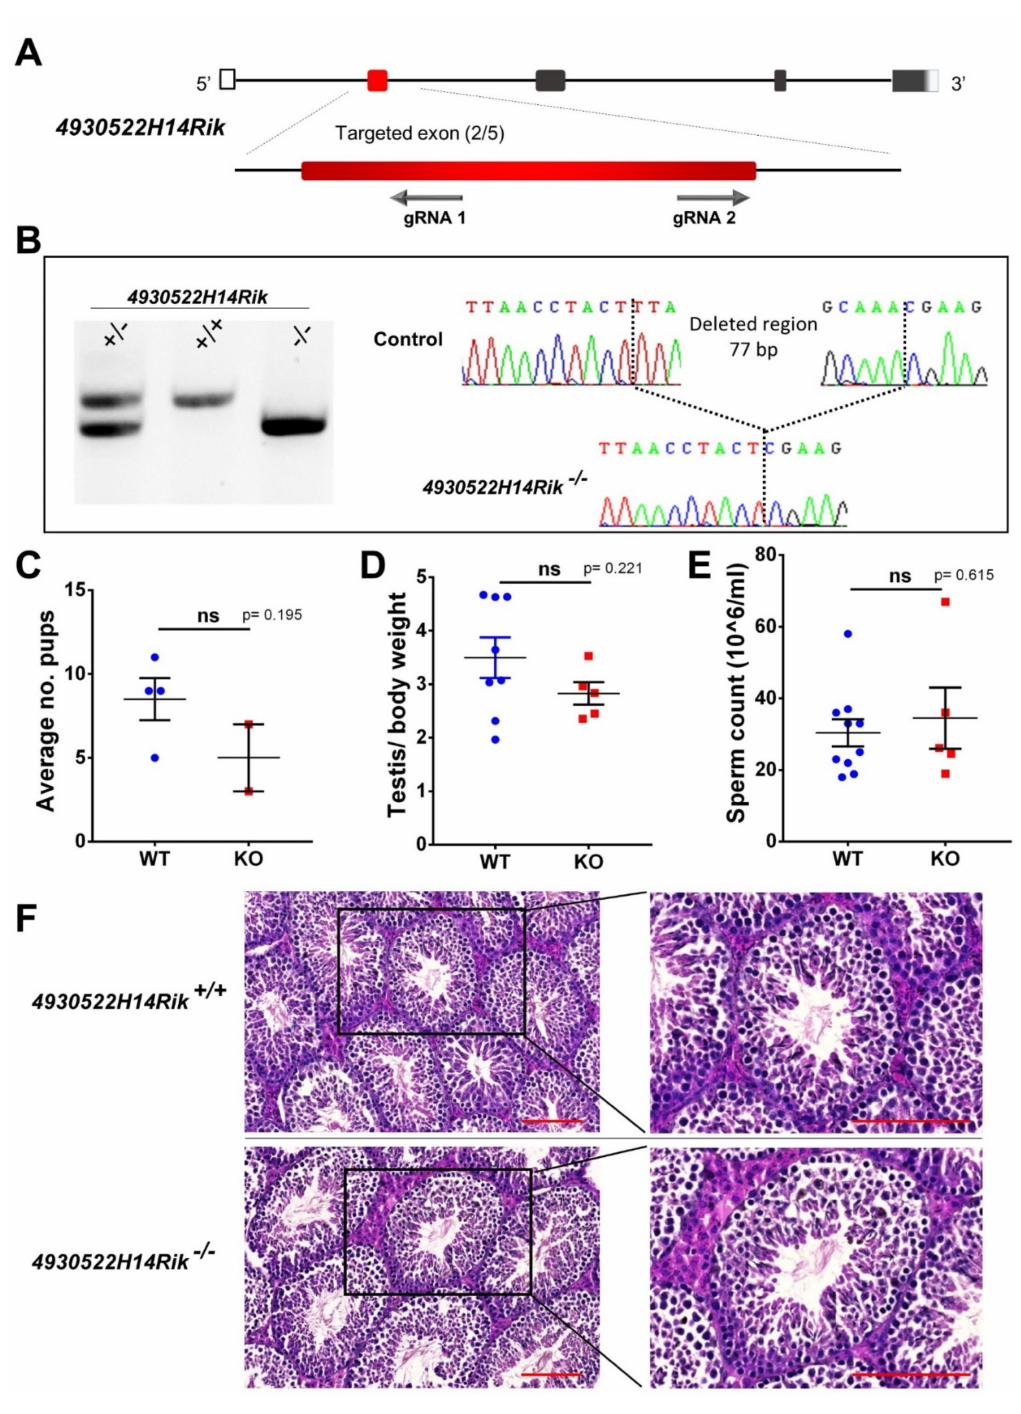
Figure 2. 4930522H14Rik editing, genotyping strategy, and phenotypic analyses of mutated animals. ( A ) Schematic presentation of 4930522H14Rik highlighting the targeted exon in red (exon 2/5) and showing the approximate location of the sequences targeted by the dual gRNAs. ( B ) Gel electrophoresis of the PCR products using a primer set that amplifies the region containing the intra-exonic deletion. DNA fragments migrate according to their molecular size (WT allele: 457 bp and KO allele: 380 bp). Genotyping strategy was completed by Sanger sequencing of PCR products for F0–F1 generations. ( C ) Average litter size of WT and KO male mice. ( D ) Comparison of testis to body weight ratios between WT ( n = 8) and KO ( n = 5) animals. ( E ) Comparison of sperm count between WT ( n = 10) and KO ( n = 5) animals. ( F ) Histological analyses of WT and KO testicular sections after hematoxylin and eosin staining. Scale bar = 100 µ